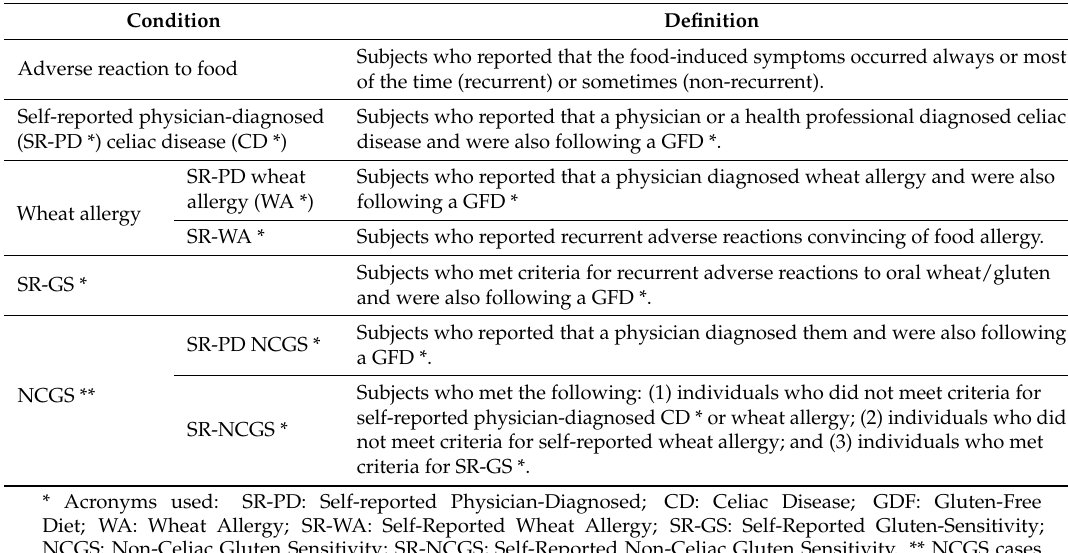
Table 1. Definitions utilized in this